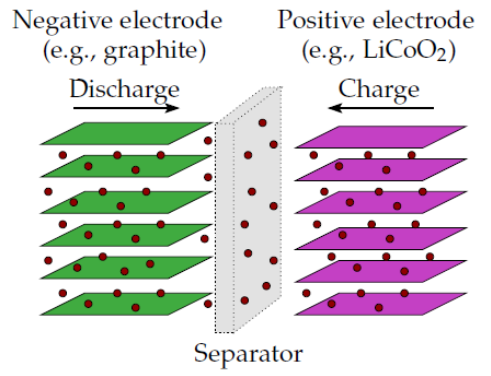
Figure 7. Schematic of Lithium-ion cell operation